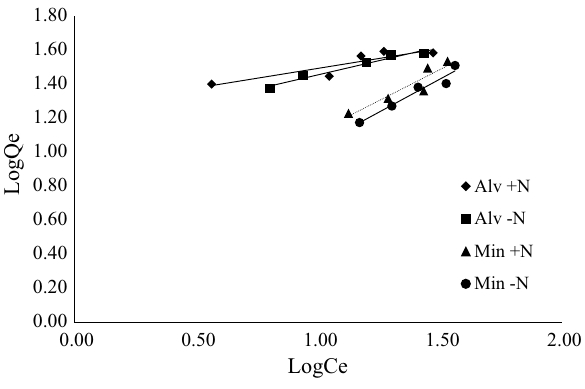
Fig. 13 Freundlich isotherm for zinc ions onto N. alveolaris + N, N. alveolaris –N, N. minuta + N, and N/ minuta –N algae